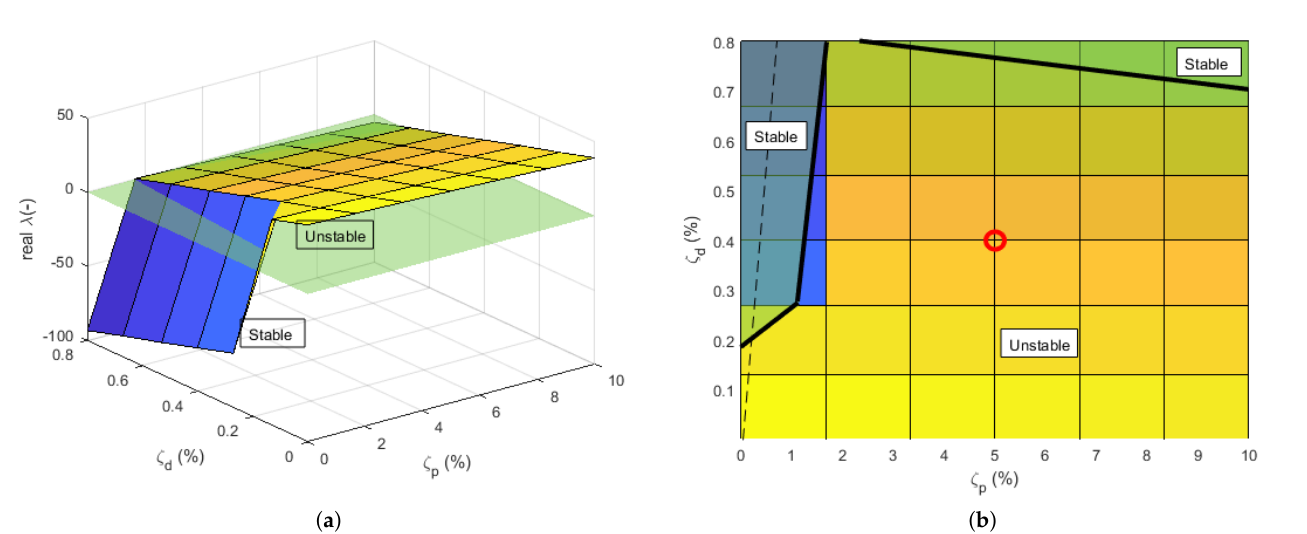
Figure 11. ( a ) Stability map with respect to ζ d , ζ p damping ratios and ( b ) stability map in the ζ d – ζ p plane. Bold lines—stability boundary, dashed line—proportional damping line, and red circle—default damping ratio